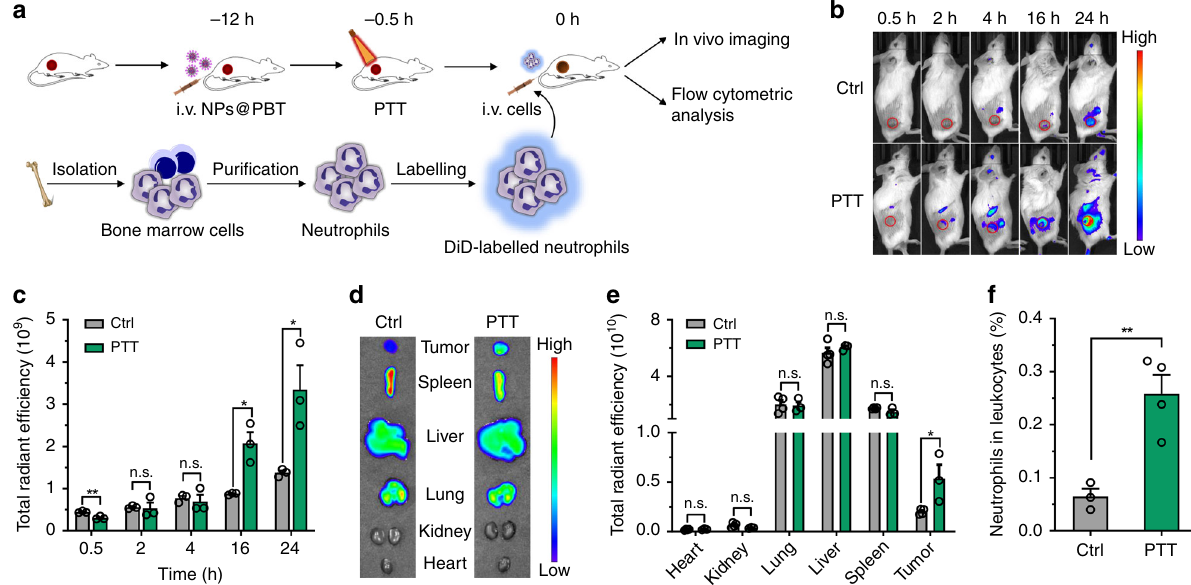
Fig. 3 PTT-created tumoral in fl ammatory microenvironment recruited adoptively transferred neutrophils. a Schematic showing analysis of the accumulation of transferred DiD-labeled neutrophils in PTT-treated EMT6 tumors. EMT6-bearing mice were i.v . injected with NPs@PBT at − 12 h and tumors were irradiated with an 808 nm laser (40 °C for 5 min) at − 0.5 h. Neutrophils were isolated from bone marrow, labeled with DiD, and i.v . injected into the mice on 0 h. b , c The distribution of transferred DiD + neutrophils in the recipient mice was analyzed with the IVIS at the indicated time points. b Representative images and c corresponding quanti fi cation of tumoral fl uorescence intensities at the indicated time points. n = 3 mice per group. d Ex vivo fl uorescence images and e corresponding quanti fi cation of total fl uorescence intensities of tumors and major organs collected at 24h post-cell transfer. n = 4 for control group and n = 3 for PTT group. f The percentage of transferred DiD + neutrophils in total DAPI − CD45 + tumor-in fi ltrating leukocytes analyzed by fl ow cytometry at 10 h post injection. n = 3 for control group and n = 4 for PTT group. Data are shown as mean ± SEM and analyzed by unpaired two-tailed Student ’ s t -test. * P < 0.05, ** P < 0.01. n. s ., not signi fi cant. Source data are provided as a Source Data fi